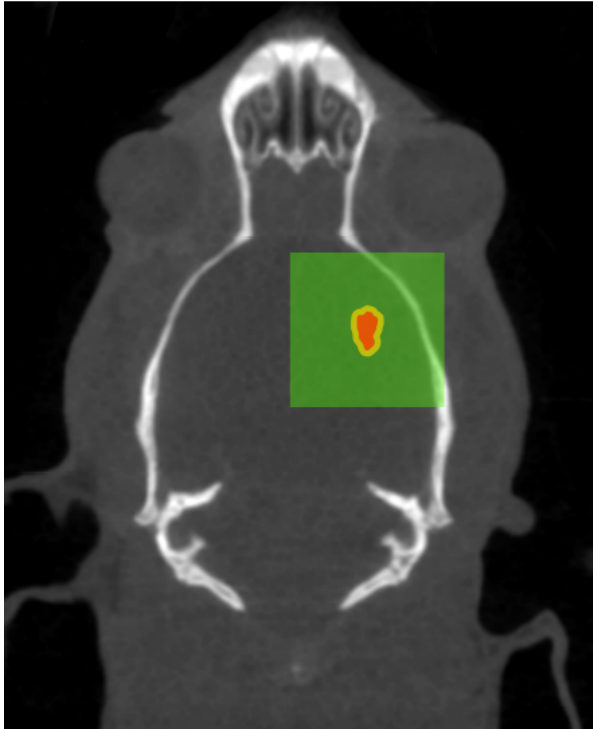
Figure 9. Coronal CT slice at 7mm depth of tumour-bearing rat, one day before treatment. Overlaid gross tumour volume summed from all tumour depths (red), target volume with 0.34mm treatment margins (yellow), and extremities of the planned 8mm × 8mm treatment field